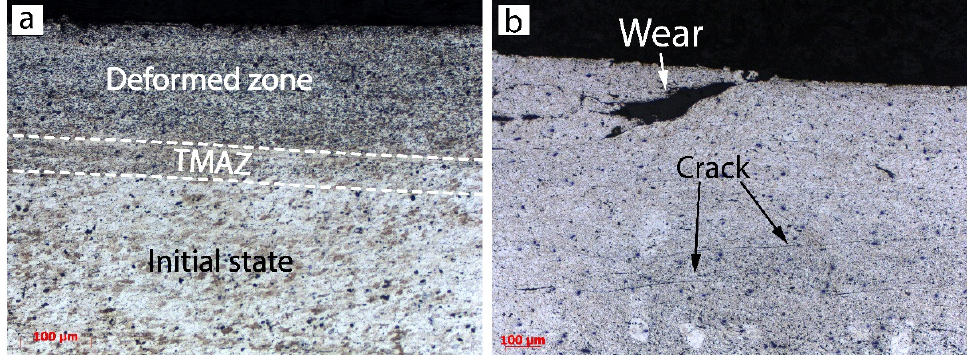
Figure 5. Microstructure in cross-section of sample AS-03: different areas of upper plate ( a ) and defects ( b ).